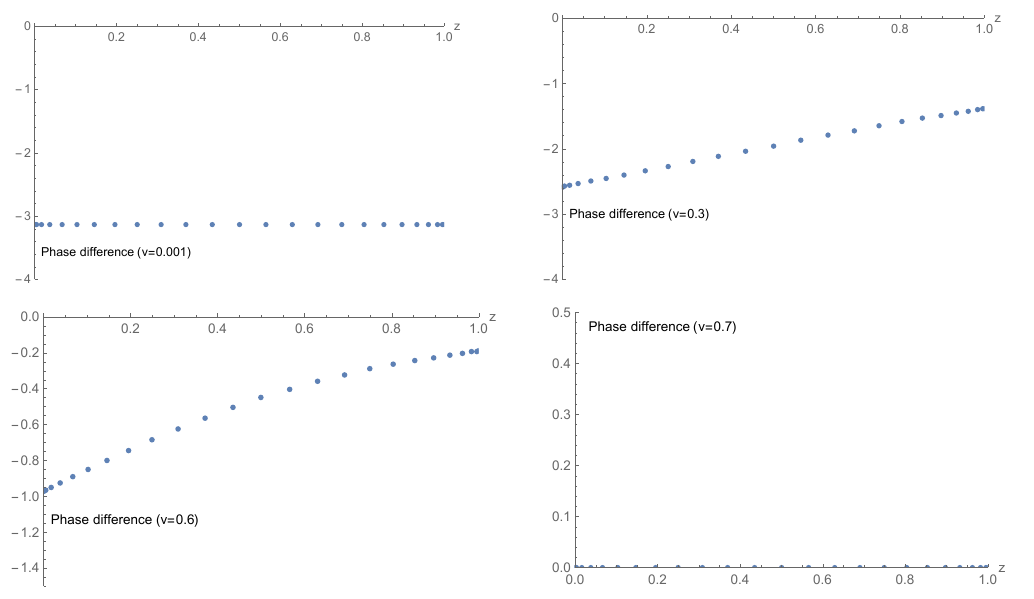
Figure 12 . The phase di(cid:11)erences at di(cid:11)erent speeds, under the standard quantization with the chemical potential (cid:22) = 5 : 5.